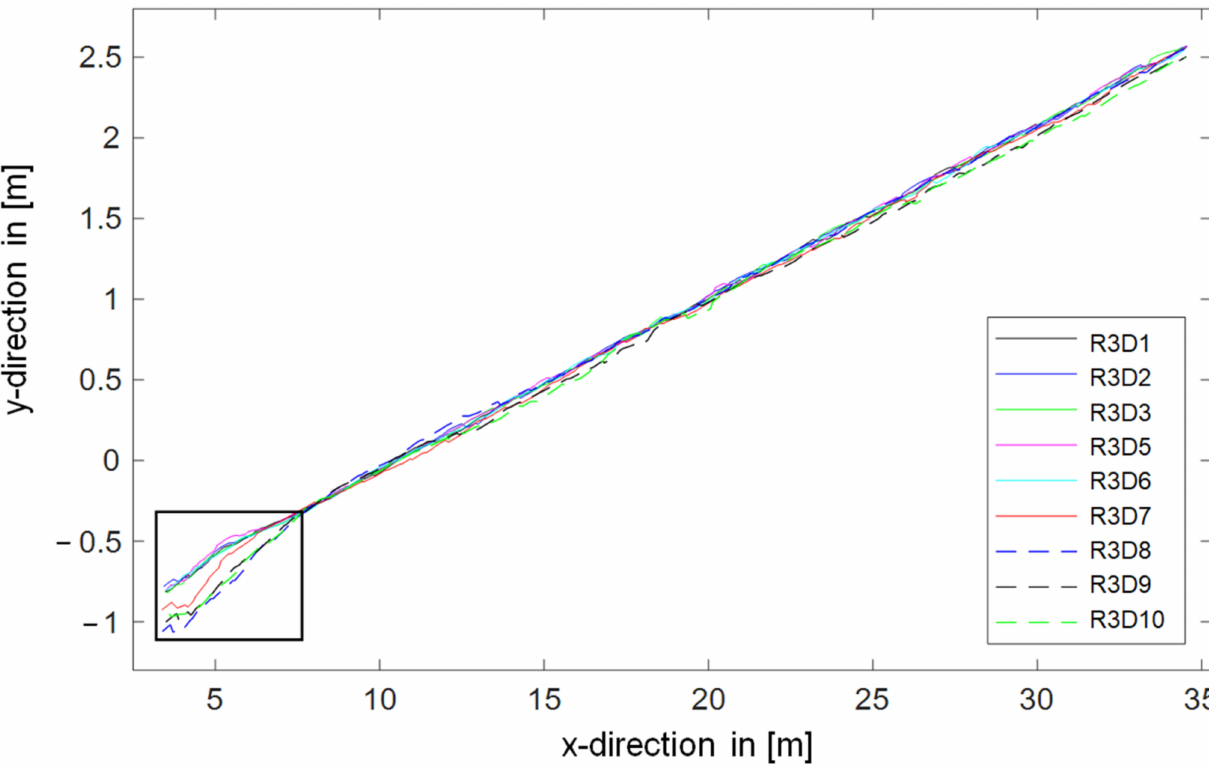
Figure 6. Plot of the nine considered test drives from run 3 in the route section [2,3].